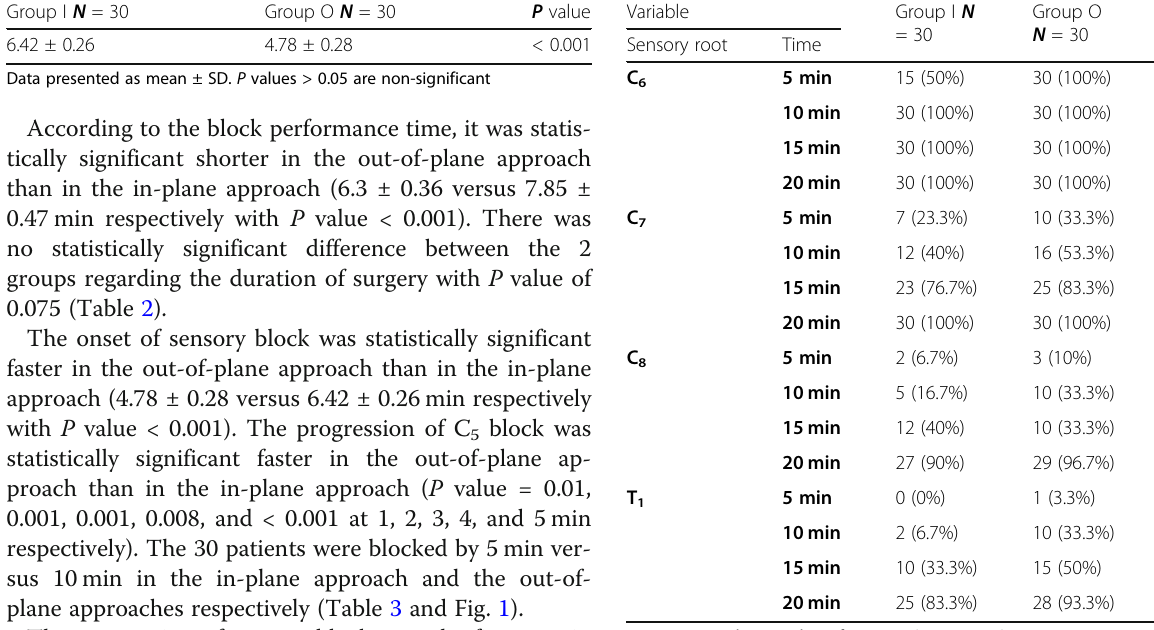
Table 3 Onset of sensory block (time to C 5 block) in minutes Group I N = 30 Group O N = 30 P value 6.42 ± 0.26 4.78 ± 0.28